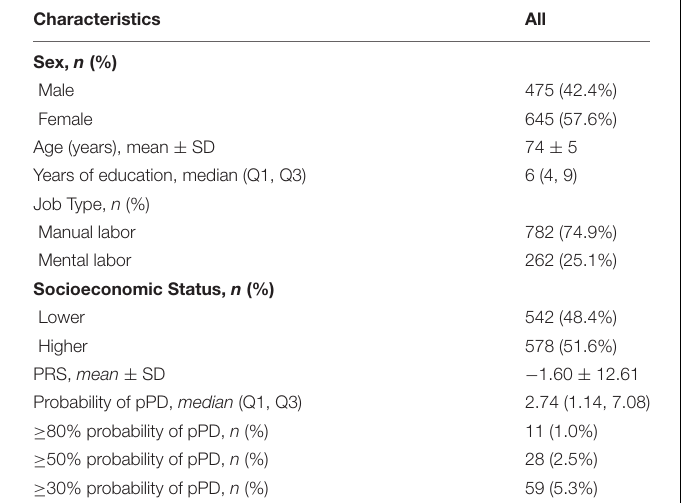
FIGURE 1 | Boxplots of PRS for those having or not 30% or more pPD probability. P -value derived from unpaired t -test.